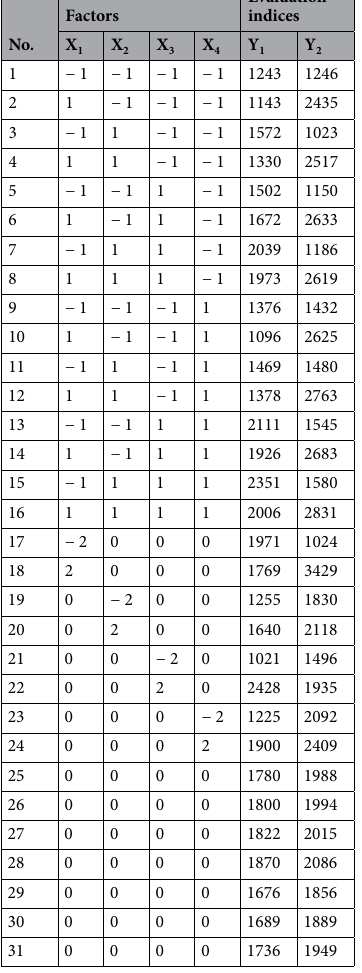
Table 4. Experiment schemes and results. Refer to Table 3. Y 1 for efficiency of conveying-soil. Y 2 for distance of the throwing-soil. The number of factors in these experiments is m = 4. The asterisk arm is of length 2. ± 2 indicates the asterisk arm experiment code. ± 1 indicates the two-level experiment code. 0 indicates the zero-level experiment code. The number of asterisk arm experiments is 2 m = 8. The number of two-level experiments 2 m = 16. The number of experiments with zero-levels was at least one. And the number of experiments with zero-levels was empirically chosen to be